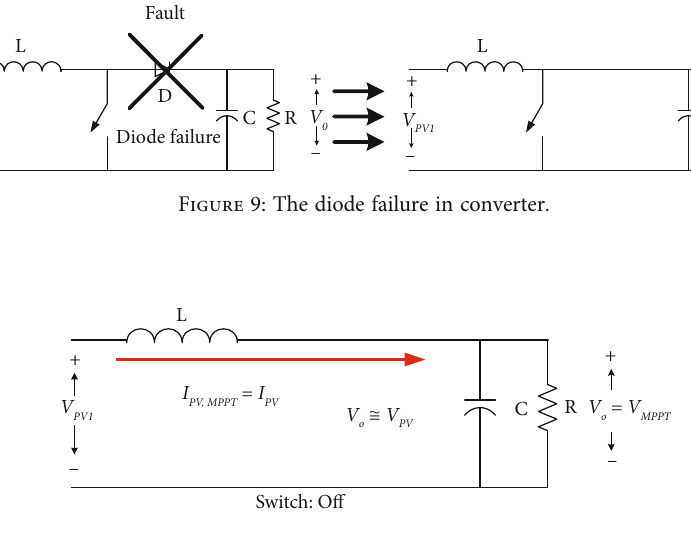
Figure 10: The circuit when the switch is open.